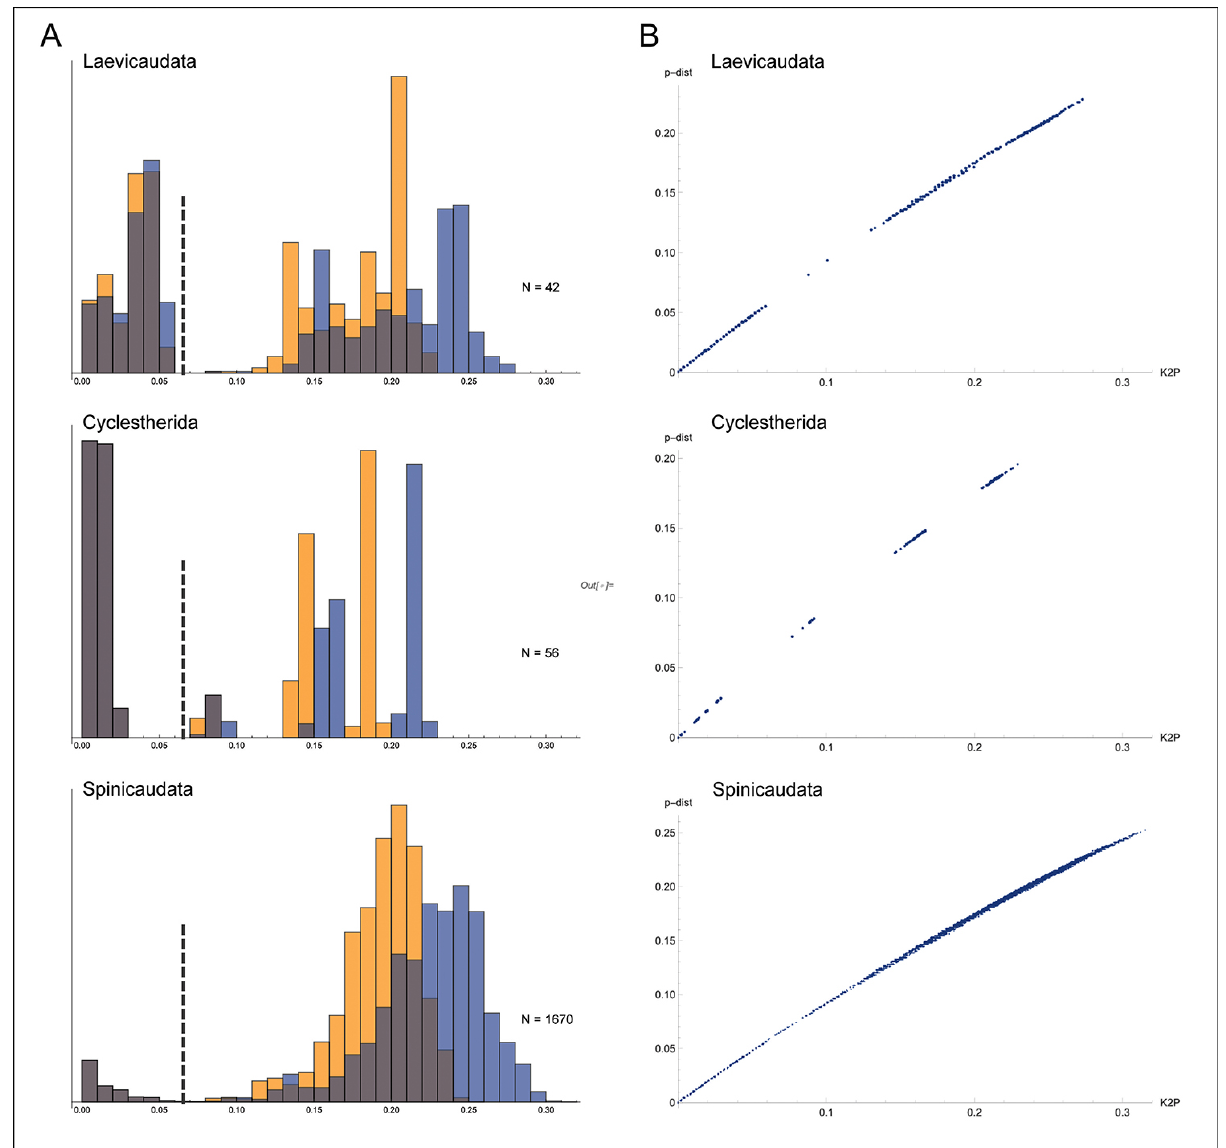
Figure 10. Genetic distances and DNA barcoding gaps in clam shrimps. A. Stacked histogram of p-distances (yellow) and K2P genetic distances (blue) between pairs of COX1 sequences available in GenBank (accession date: 11/11/2018) for every suborder of clam shrimp (Laevicaudata, Spinicaudata, and Cyclestherida). The presence of a DNA barcoding gap is highlighted with a dashed vertical line. B. Saturation plot showing the strong correlation between p-distances and corrected genetic distances (Kimura